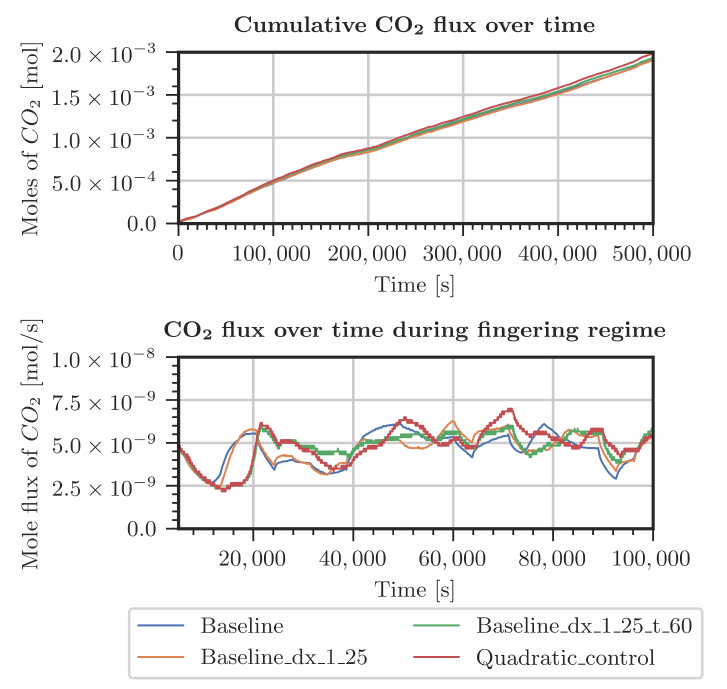
Figure A4. Comparison of CO 2 entering the system for various grids (Table A1). Measured pressure and CO 2 concentration at the top